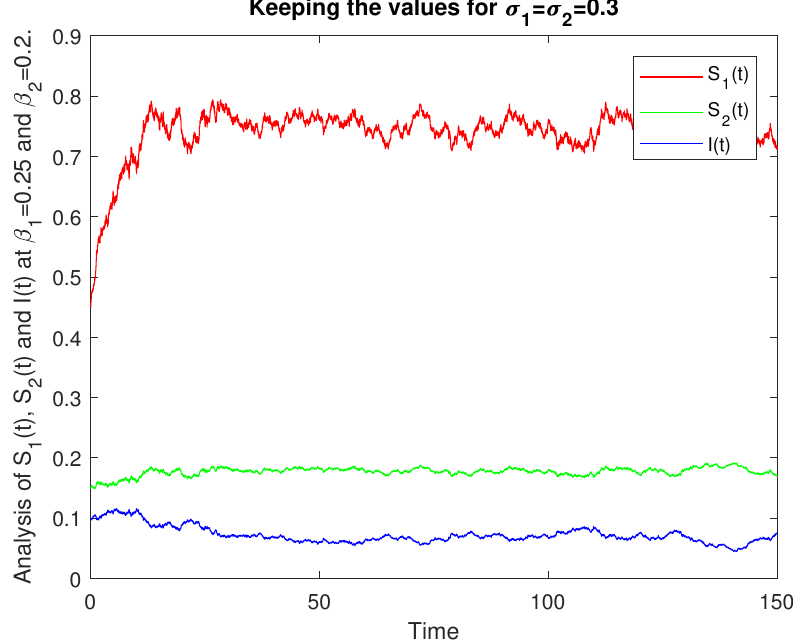
Figure 8. Comparative analysis of S 1 ( t ) , S 2 ( t ) , I ( t ) for β 1 = 0.25, β 2 = 0.2.